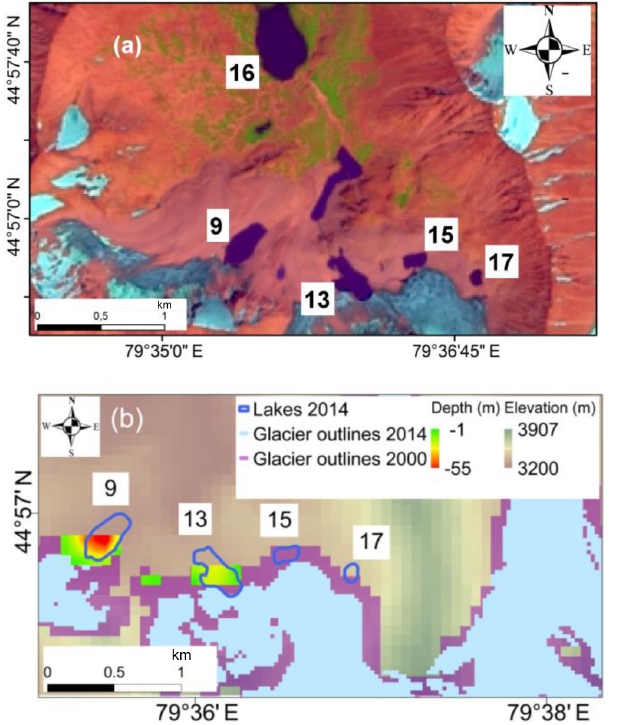
Figure 10. (a) Cascades of lakes in the Bien River basin (Land- sat scene from 2014) and (b) modelled overdeepenings using the glacier mask from 2000 and actual lakes as in